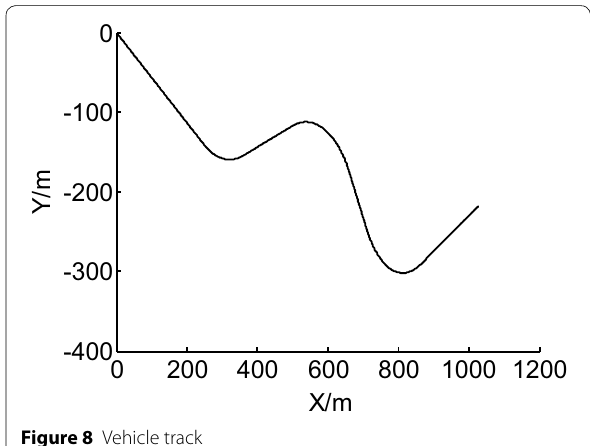
Figure 8 Vehicle track